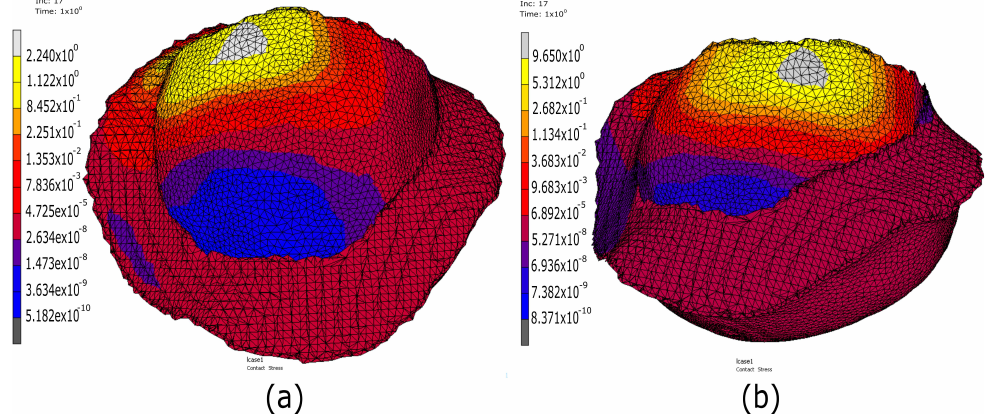
Figure 9. Contact pressures distribution obtained in the cartilage: ( a ) healthy hip joint ( b ) Cam-type femoroacetabular impingement hip